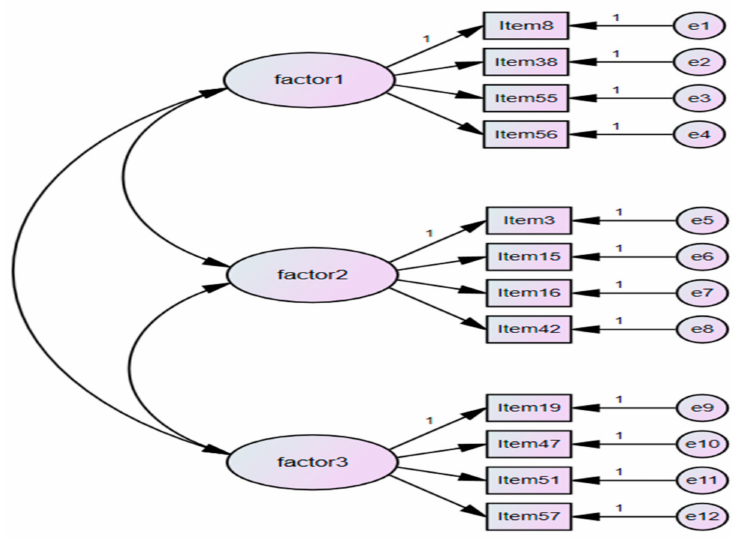
Figure 2. Confirmatory factor